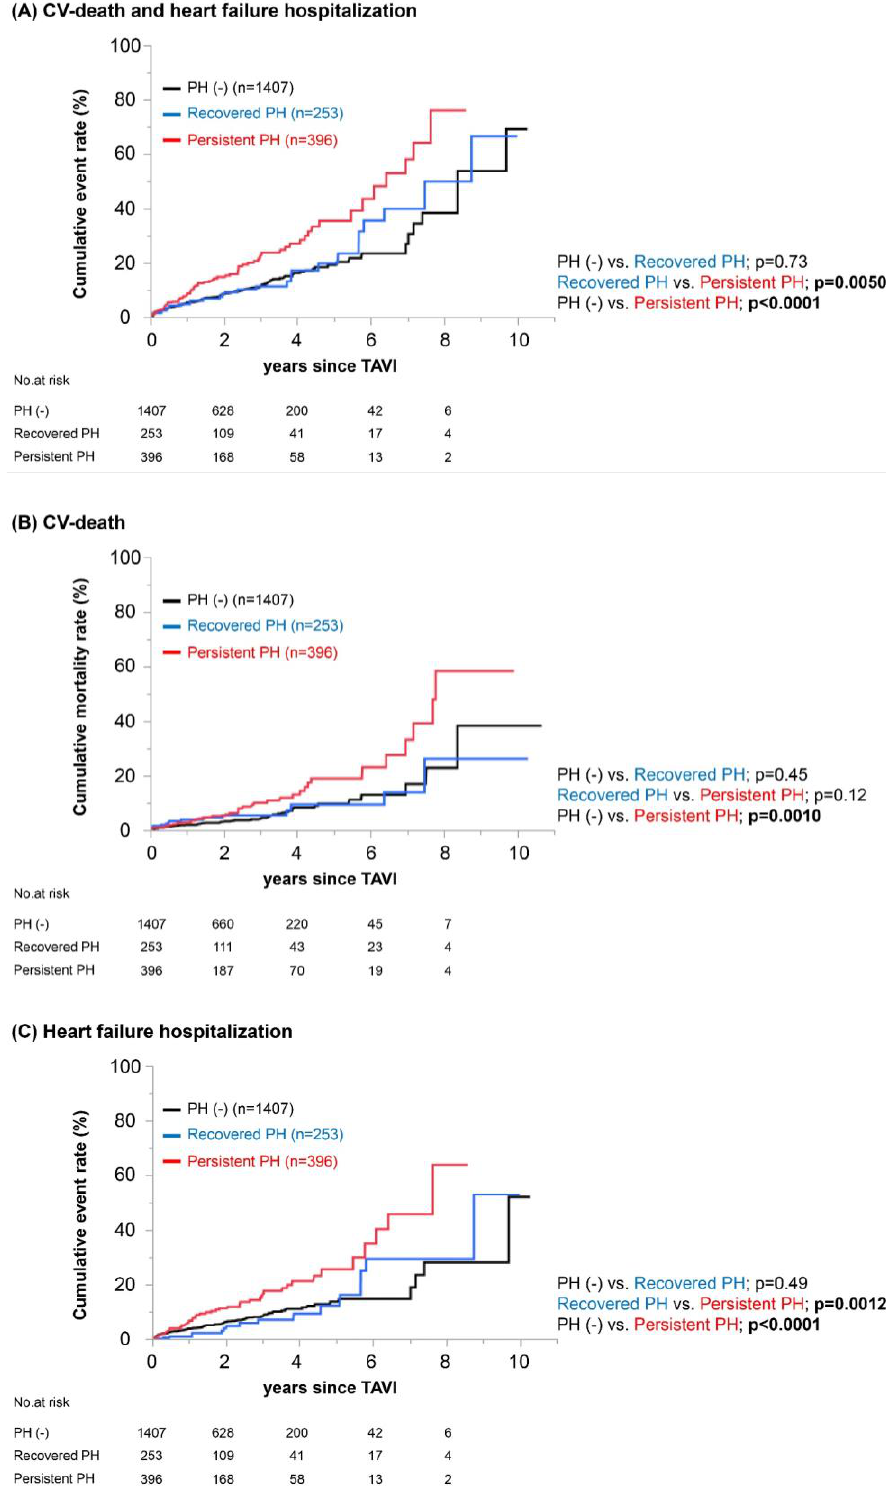
Figure 1. Long-term outcomes following TAVI in the PH ( − ), Persistent PH and Recovered PH groups. Figure legend: Kaplan-Meier estimates of patients in PH ( − ) (black), Recovered PH (blue) and Persistent PH (red) groups and survival tables indicating cumulative incidences of composite CV-death and heart failure hospitalization ( A ), CV-death ( B ) and heart failure hospitalization ( C